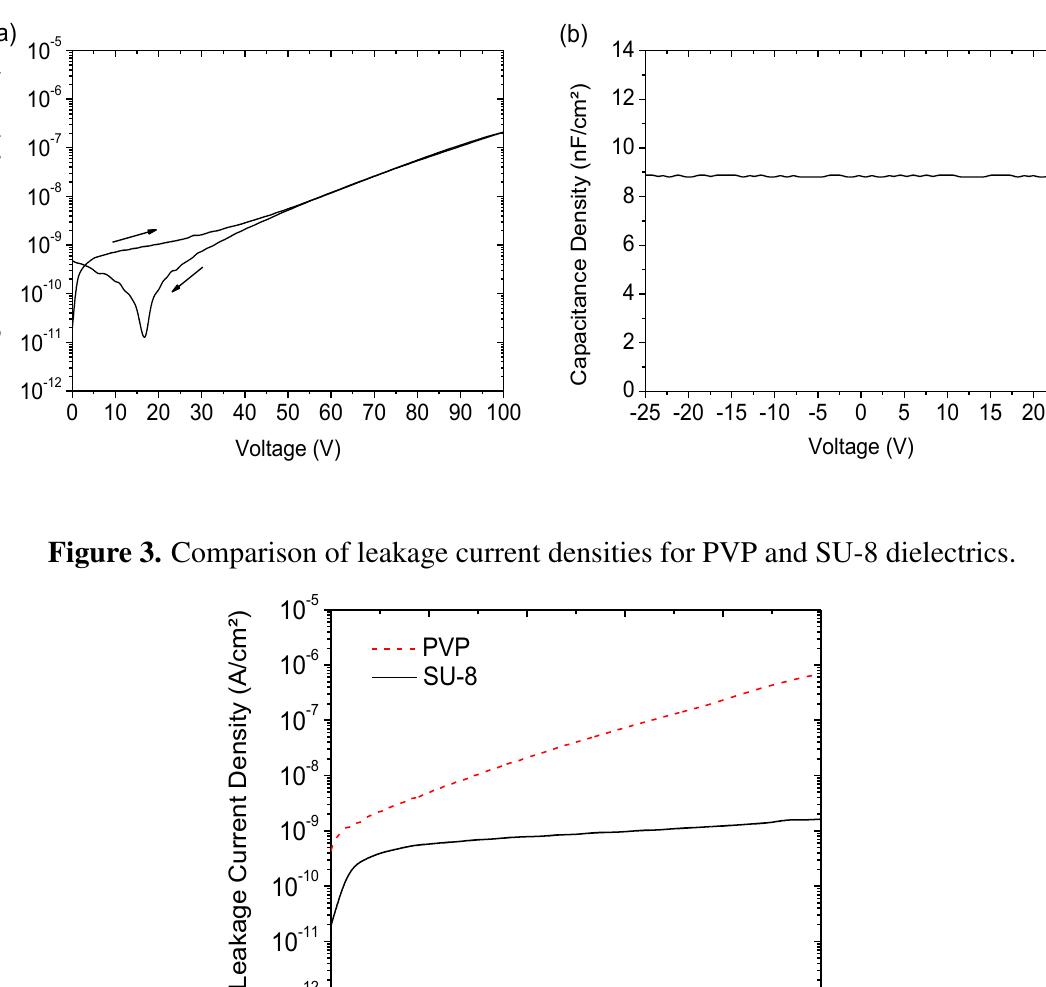
Figure 2. ( a ) Leakage current density and ( b ) capacitance density measurement for SU-8 dielectric films with thicknesses of 305 nm.